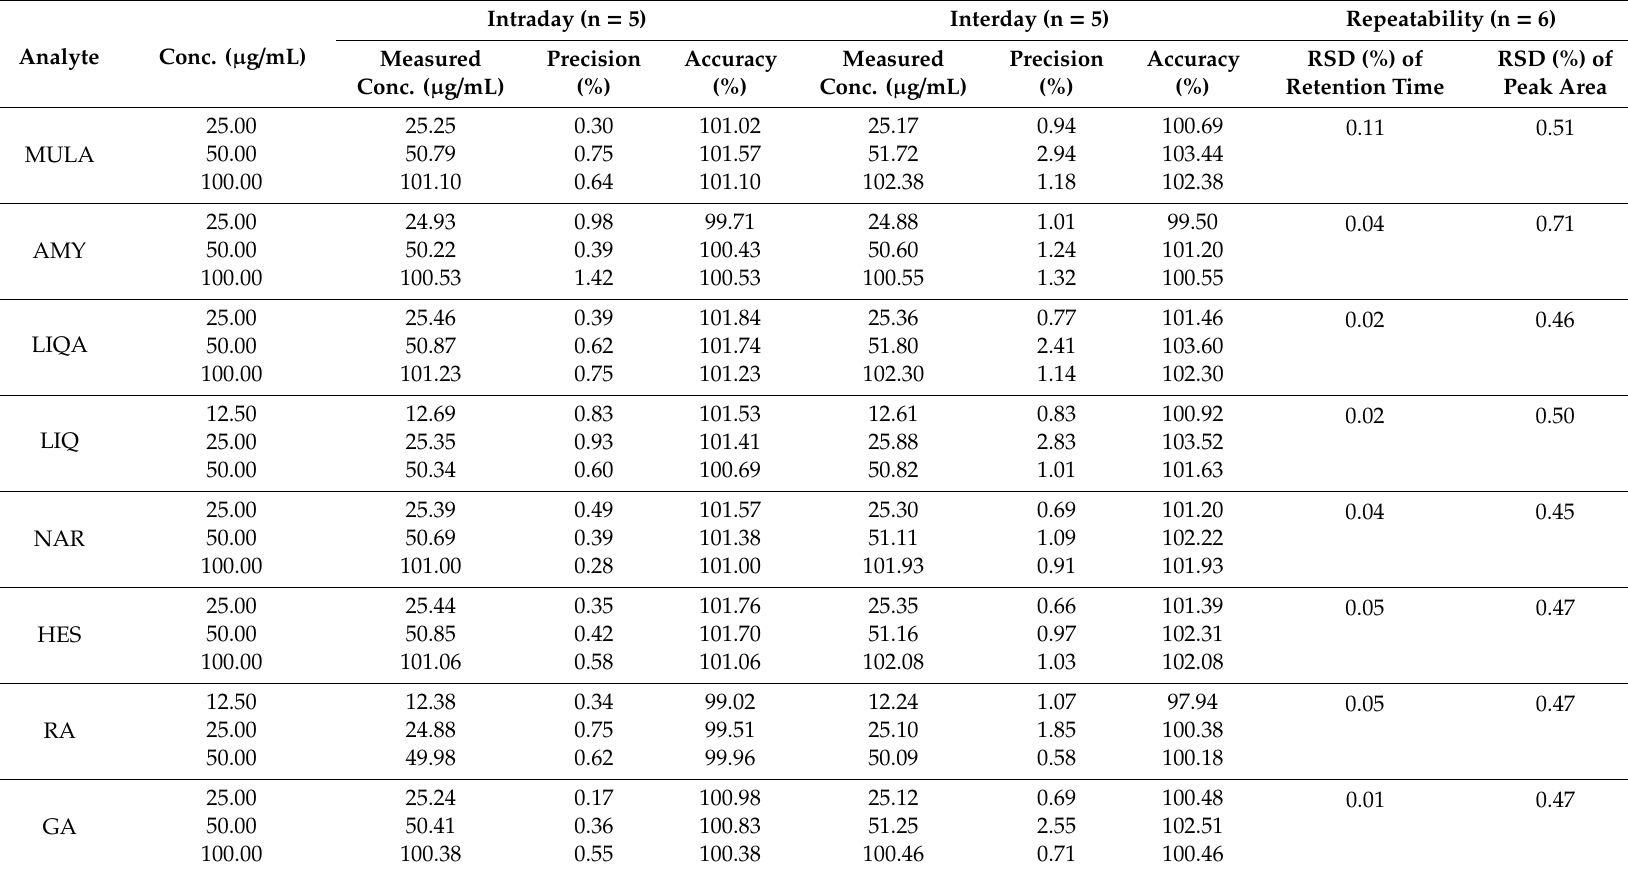
Table 3. Precision assay for the eight analytes in